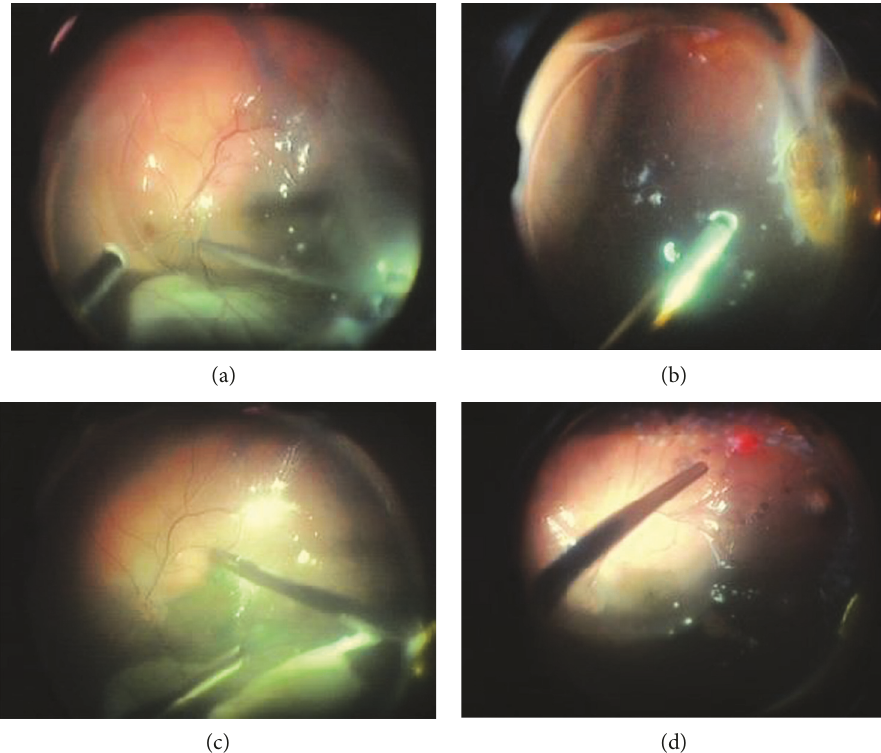
Figure 1: Scenes to document essential surgical steps: (a) fi lling of per fl uorocarbon liquids (PFCL); (b) trimming necrotic retina tissue edges; (c) peeling of the inner limiting membrane after staining with indocyanine green; (d) laser coagulation of the retina edges after exchange of the PFCL against air before instillation of silicone